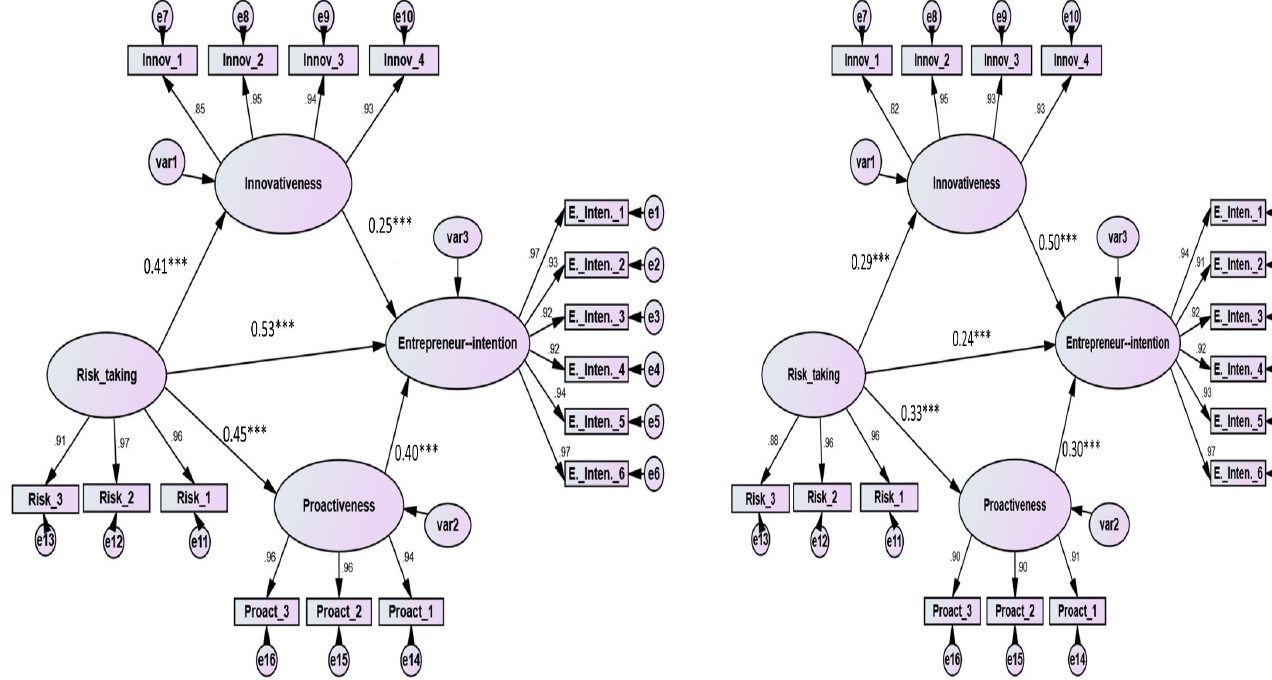
Figure 3. The male and female models in this study (*** = significant level less than 0.001).